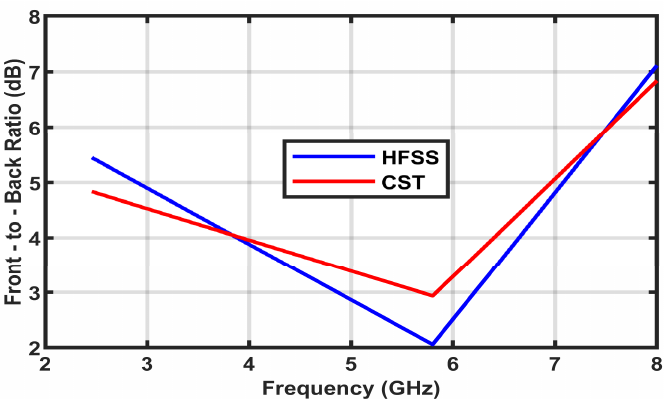
Figure 11. Analysis of antenna’s front-to-back ratio (FBR) in HFSS and CST.